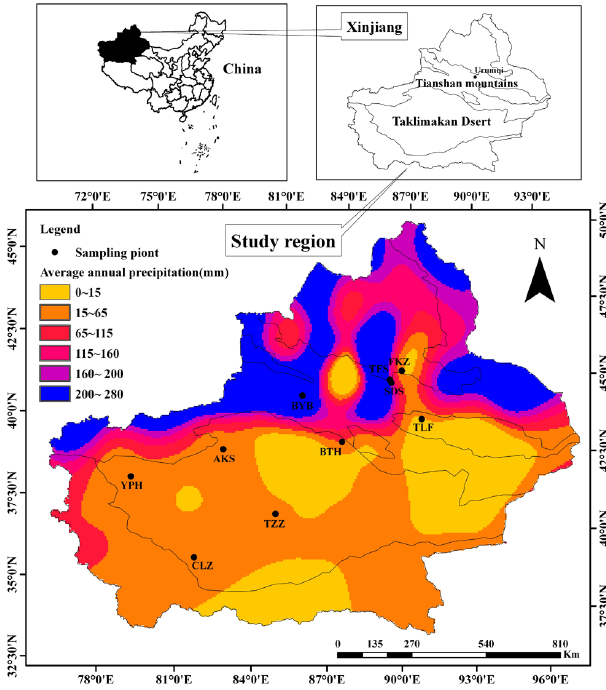
Fig. 1. Distribution of the ten monitoring sites in the Xinjiang arid region of northwest